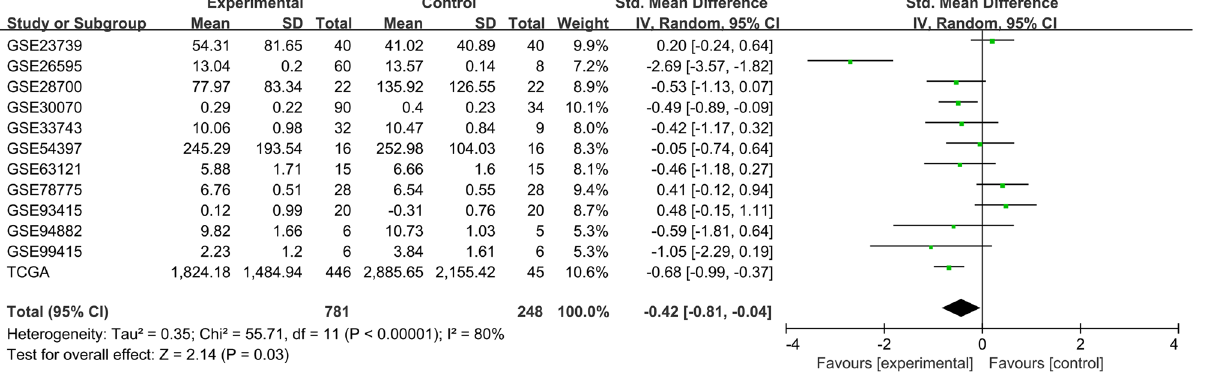
Figure 1. Expression of miR-30c-5p in gastric cancer tissues compared with normal gastric tissues. (GXYLT2 was highly expressed in GC tissues based on TCGA database and GEO database showing in forest